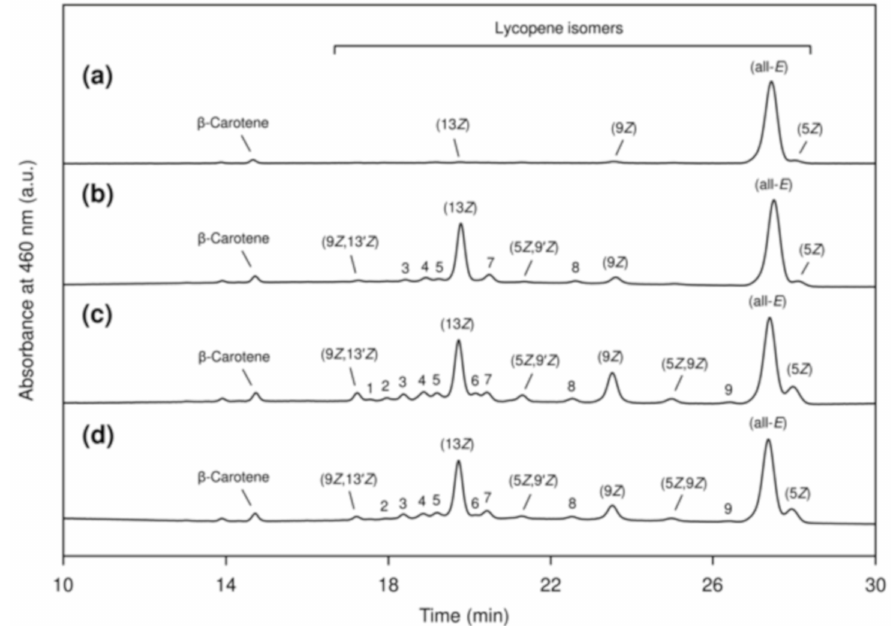
Figure 3. Normal-phase HPLC chromatograms of ( a ) extraction raw material (tomato pulp) and extracts obtained ( b ) without foodstuffs, and with ( c ) onion and ( d ) mustard using ethyl acetate at 70 ◦ C for 1 h. (all- E )-, (5 Z )-, (9 Z )-, (13 Z )-, (5 Z ,9 Z )-, (5 Z ,9 (cid:48) Z )-, and (9 Z ,13 (cid:48) Z )-Lycopene designated in the chromatograms were identified according to the previous studies [2,14,15,22–24]. The peaks (1–9) were unknown lycopene Z -isomers [2,22].